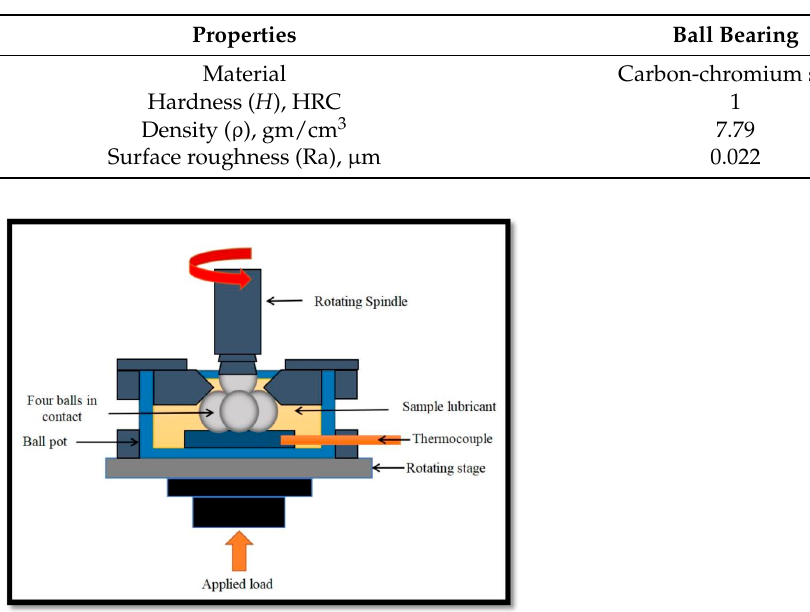
Table 2. The mechanical details of the metal ball bearing.